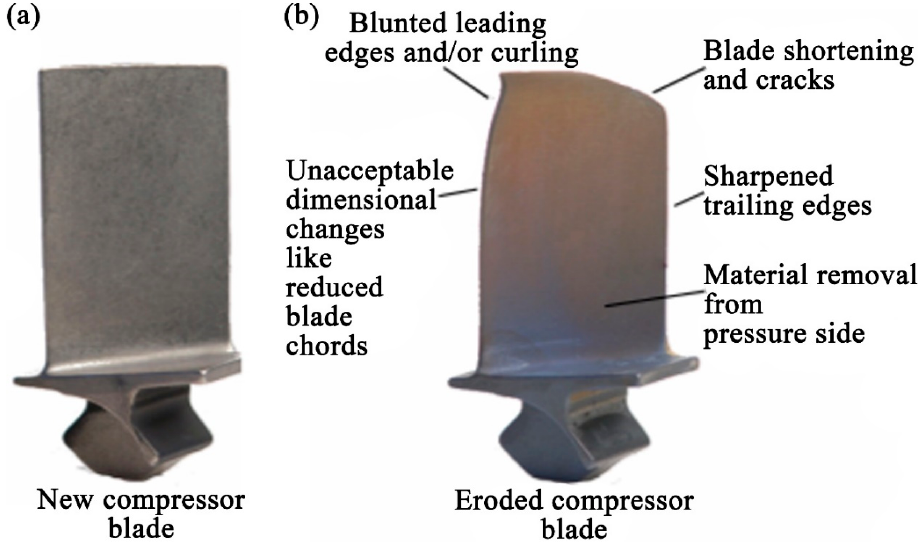
Figure 6. GTE compressor blades, where ( a ) demonstrates a new blade, and ( b ) shows the blade after experiencing SPE [50].